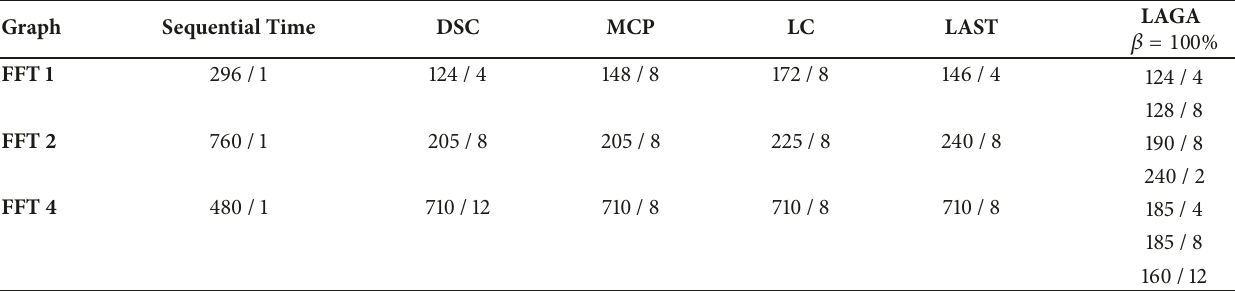
Table 6: Comparison of LAGA with well-known nongenetic algorithms considering the number of processors on FFT benchmarks (completion time/#processor used).